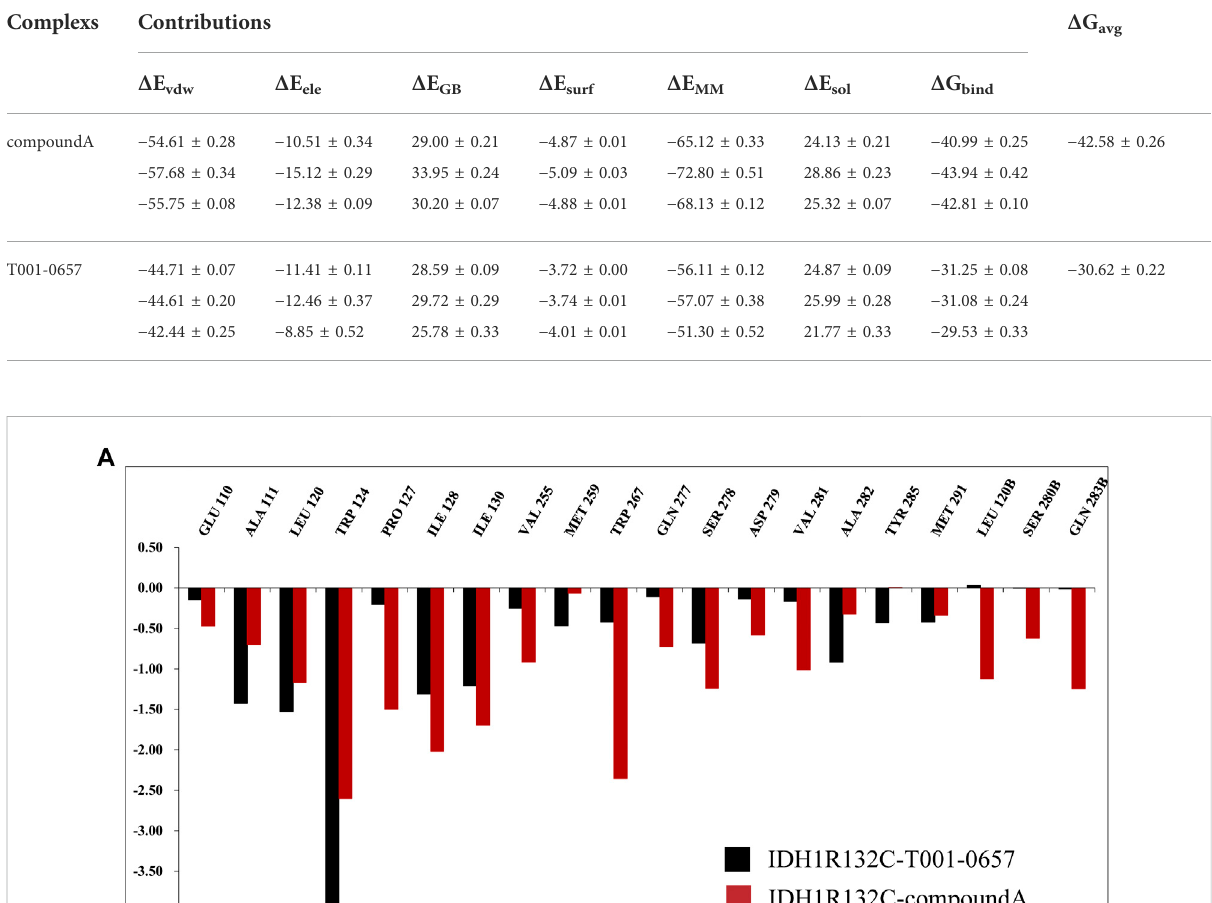
TABLE 4 The binding free energy contributions of compound A and T001-0657 to IDH1-R132C calculated using the MM-GBSA method (kcal/mol).